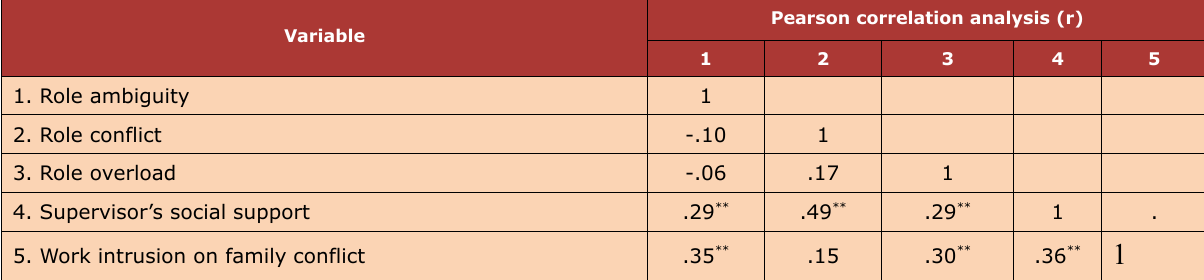
Table 5. Pearson correlation analysis and descriptive